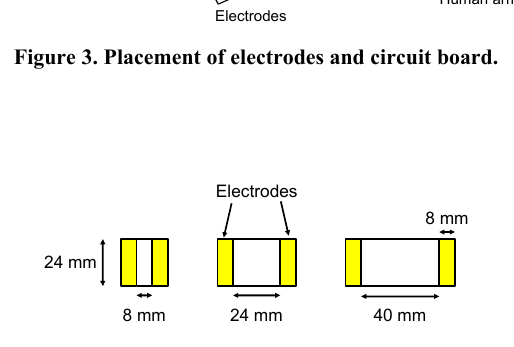
Figure 4. Configurations of transmitter electrodes.